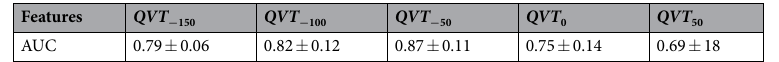
Table 7. AUC values of the C QVT classifier as a function of parameter S